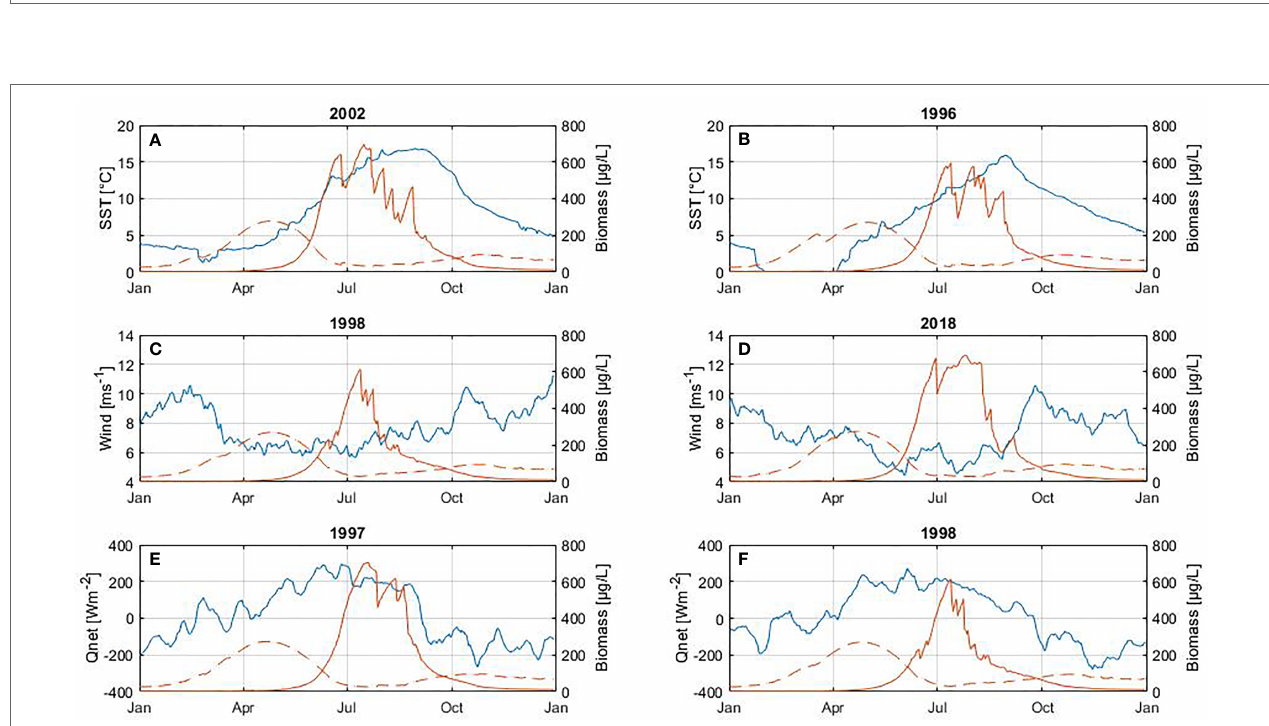
FIGURE 9 | Influence of SST (A, B) , wind (C, D) and net heat flux (E, F) on cyanobacteria biomass (between June and August). At the top of each plot is shown the year with the highest positive anomalies (left panel) and negative anomalies (right panel) foreach variable. The blue line corresponds to the variable (left axes) and the red line to biomass (right axes) of diatoms (dashed line) and cyanobacteria (solid line). The diatom bloom is included only to illustrate its inter-annual